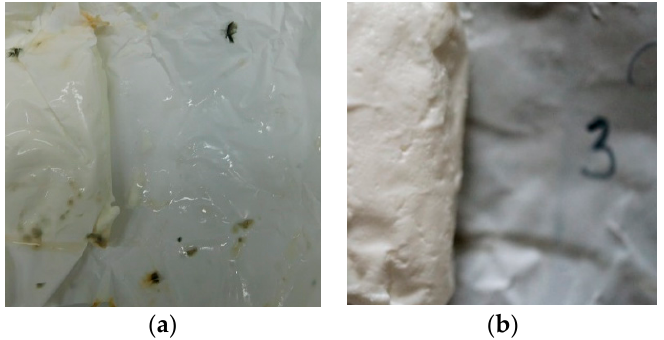
Figure 6. Goat cream cheese after five-week storage at chilled temperature (4 ◦ C +/ − 2 ◦ C) wrapped in polyolefin foil with PLA coating ( a ) or polyolefin foil with ZVI / PLA coating ( b